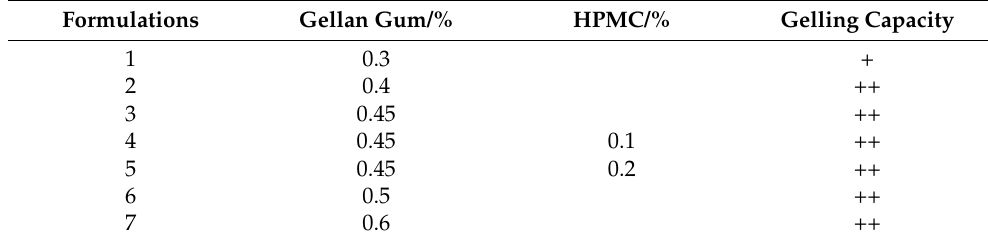
Table 1. The gelling capacity of the formulations.